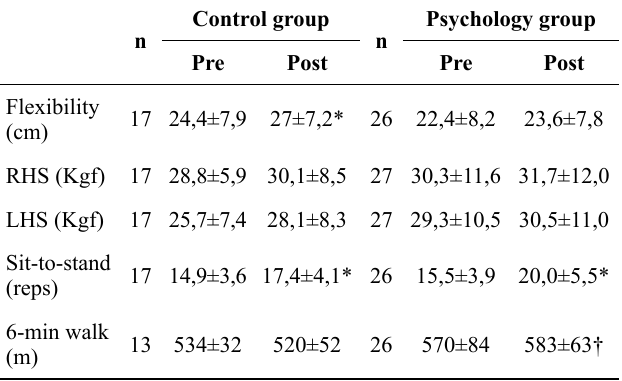
Table 2: Flexibility, right-hand handgrip strength (RHS), left-hand handgrip strength (LHS), sit-to-stand and 6-min walk.